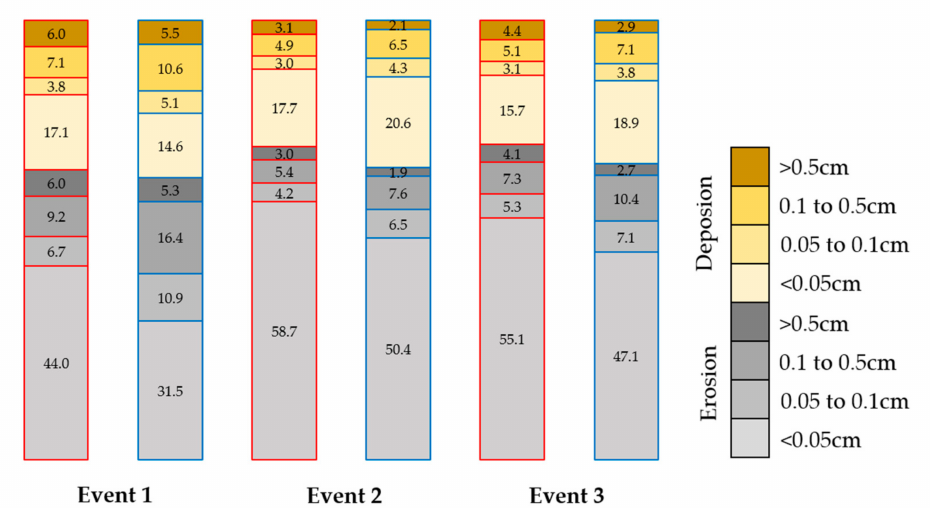
Figure 7. Area of erosion/deposition (in %) corresponding to various magnitudes predicted by the KR method (in red) and the EH method (in